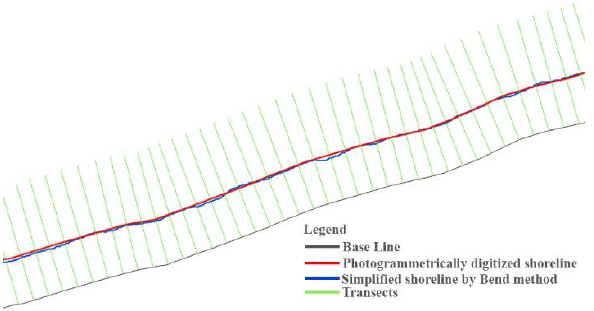
Figure 5. Results of Douglas-Peucker and Bend methods.